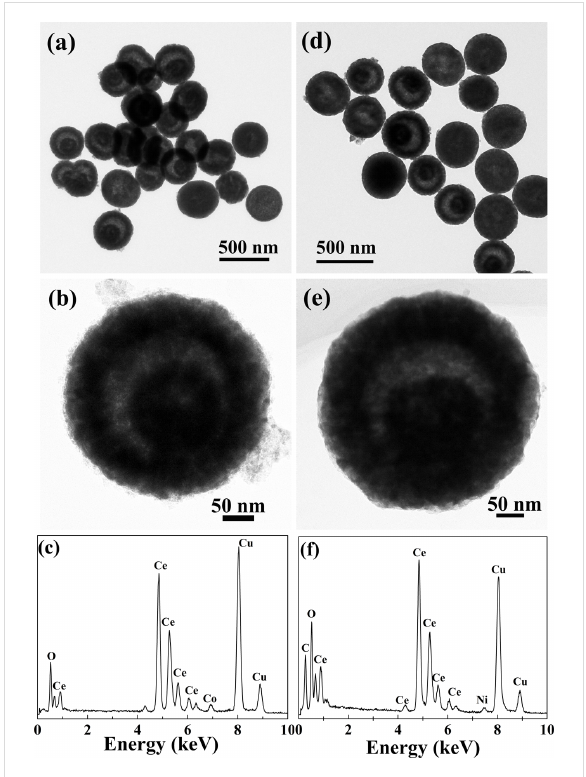
Figure 5: TEM images and the corresponding EDX patterns of the synthesized CeO 2 –CoO x (a–c) and CeO 2 –NiO (d–f) composite yolk–shell